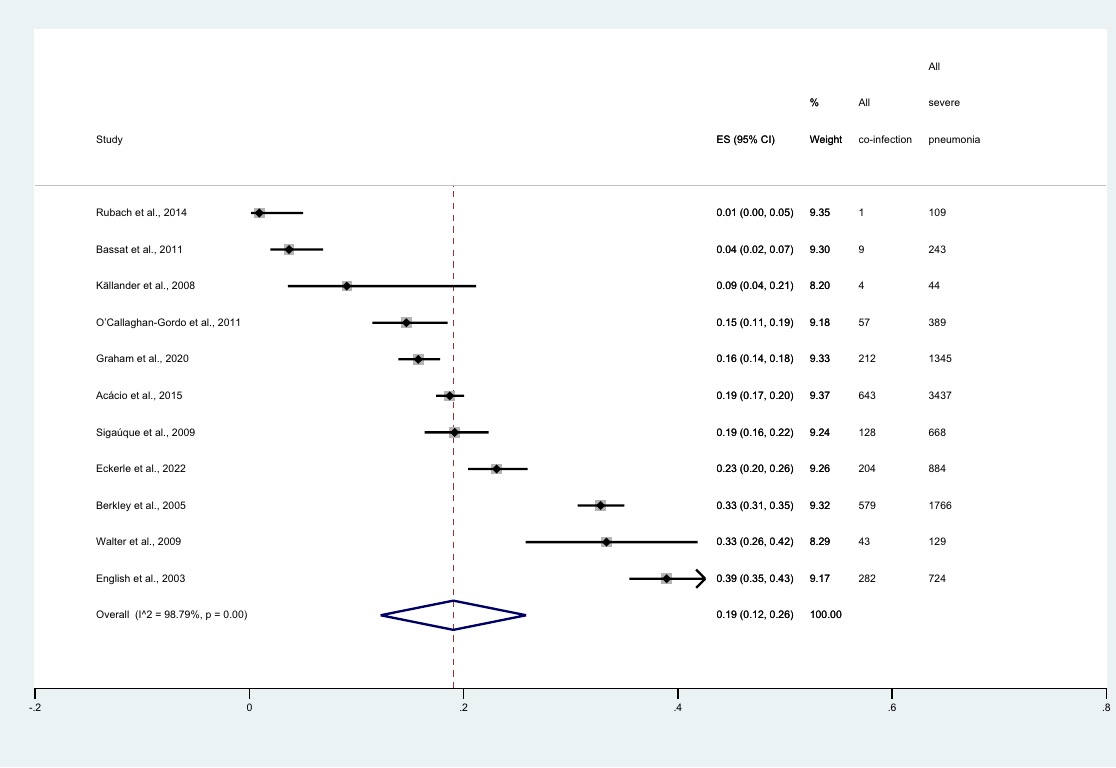
Figure 2. Forest plot demonstrates the pooled proportion of malaria among patients with severe pneumonia. ES, proportion estimate; CI, confidence interval.